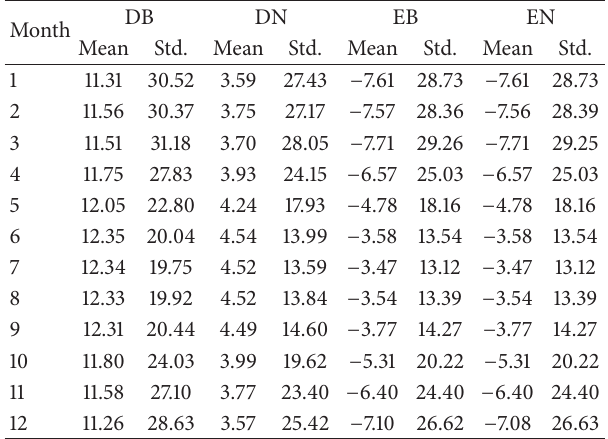
Table 2: Simulated effects of afforestation on albedo in Jiangxi Province (magnified by 10 −3 ). DB DN EB EN Month Mean Std. Mean Std. Mean Std. Mean